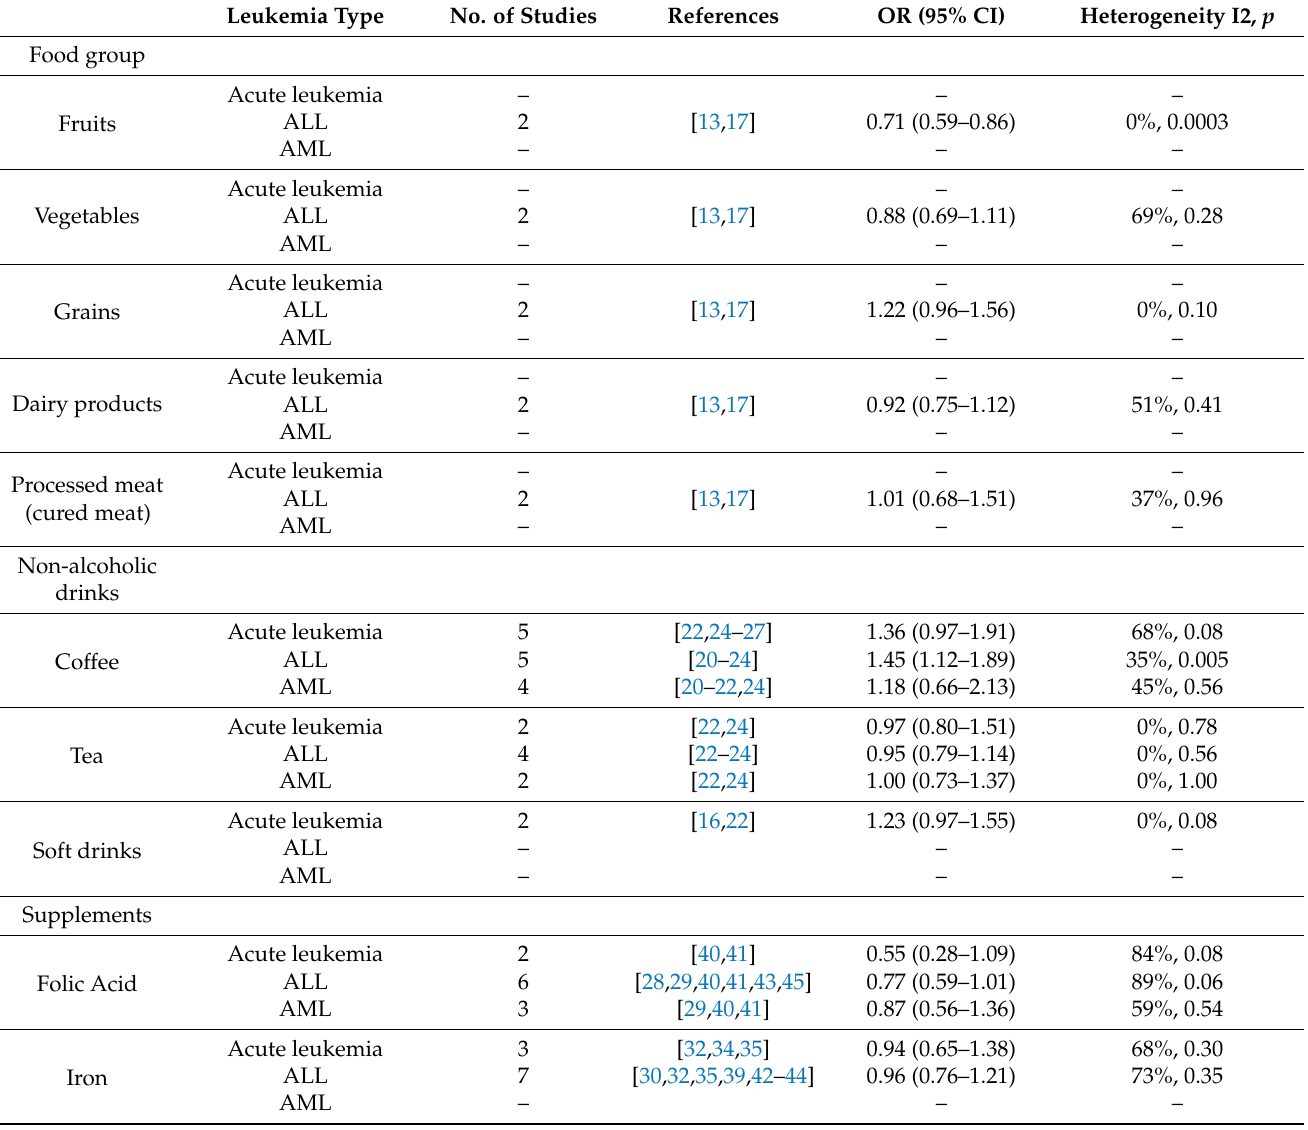
Table 11. Summary Odds Ratios (ORs) and 95% Confidence Intervals (CIs) obtained in meta-analysis of data from referenced published studies of association of childhood leukemia with maternal dietary